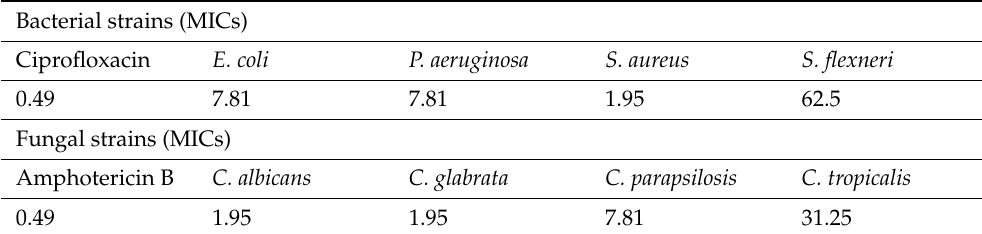
Table 1. Minimum inhibitory concentration (MIC) values ( µ g/mL) of the mangiferin isolated from M. indica leaves against bacterial and fungal pathogenic strains. Ciprofloxacin and amphotericin B were the positive